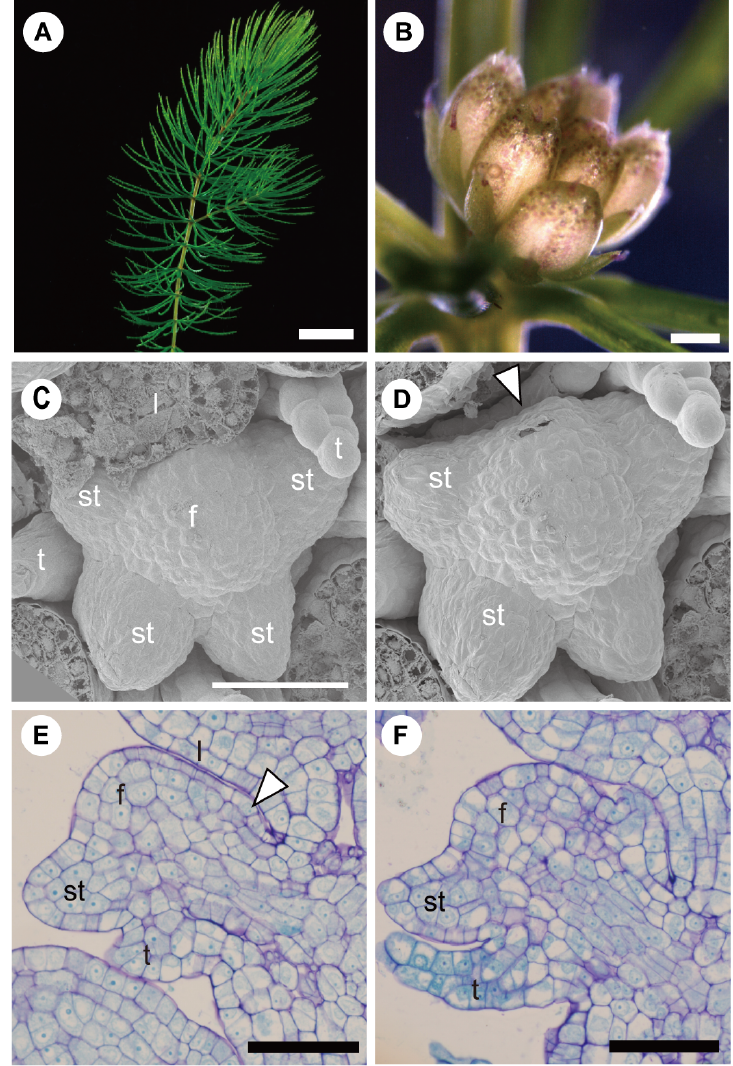
Figure 7. Adaxial developmental inhibition in staminate flower of Ceratophyllum demersum : ( A ) shoot of Ceratophyllum demersum in aquatic environment. ( B ) Staminate flower consisting of numerous stamens and surrounding tepal/bracts. ( C ) Staminate floral primordium at an early stage. Abaxial and lateral stamen primordia are initiated. Adaxial side of primordium is covered (contacted) with leaf primordium. ( D ) Same floral primordium in (C). Leaf primordium at adaxial side of floral primordium was removed. No stamen primordium is initiated at the adaxial side (white arrowhead). ( E ) Stamen and tepal/bract primordium initiated on the abaxial side and just bulge found on the adaxial side (white arrowhead) in staminate floral primordium at an early stage. Note that an upper leaf primordium tightly contacts with the adaxial side of floral primordium. ( F ) Staminate floral primordium at a slightly later stage than that in (E). Tepal/bract primordium is initiated on the adaxial side, but no stamen primordium is initiated on same side. Abbreviations: t, tepal or bract primordium; f, floral apex; l, leaf primordium; st, stamen primordium. Scale bar in A = 5 mm, in B = 500 µm, in C – F = 50 µm. (( A , B , E , F ) reproduced from Iwamoto et al., 2015; ( C , D ) from Iwamoto et al., 2003) [31,32].